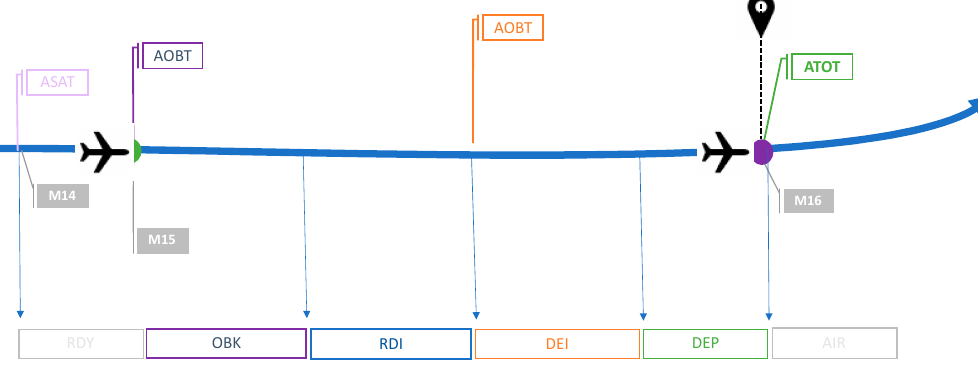
Figure 5. The outbound phase of the flight on the milestone approach and its nomenclature.